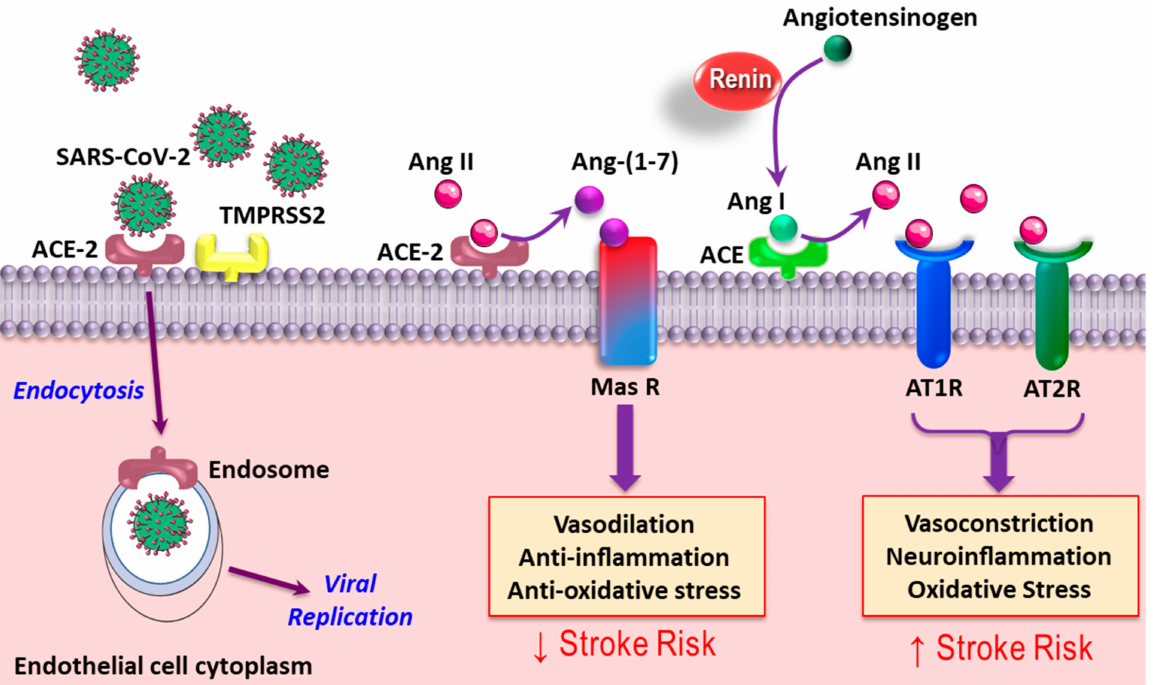
Figure 2. Schematic effects of SARS-CoV-2 on the renin–angiotensin system (RAS) in the cerebral vasculature. After the binding of the SARS-CoV-2 spike (s) glycoprotein to angiotensin converting enzyme 2 (ACE-2), the virus enters the cell. The virus also downregulates ACE-2 and competes with angiotensin II (Ang II) for binding to ACE-2, which ultimately decreases the activity of the ACE-2-Ang-(1-7)-Mas receptor (alternative) axis. This also leads to the greater activation of the ACE-Ang II-AT1R (classical) axis. The outcome of such events is an aberrant renin-angiotensin system (RAS), causing vasoconstriction, inflammation, oxidative stress, and thrombogenesis, causing ischemic stroke in relation to severe acute respiratory syndrome coronavirus 2 (SARS-CoV-2) infection. SARS-COV-2. TMPRSS2, Transmembrane protease, serine 2; AT1R: angiotensin 1 receptor; AT2R: angiotensin 2